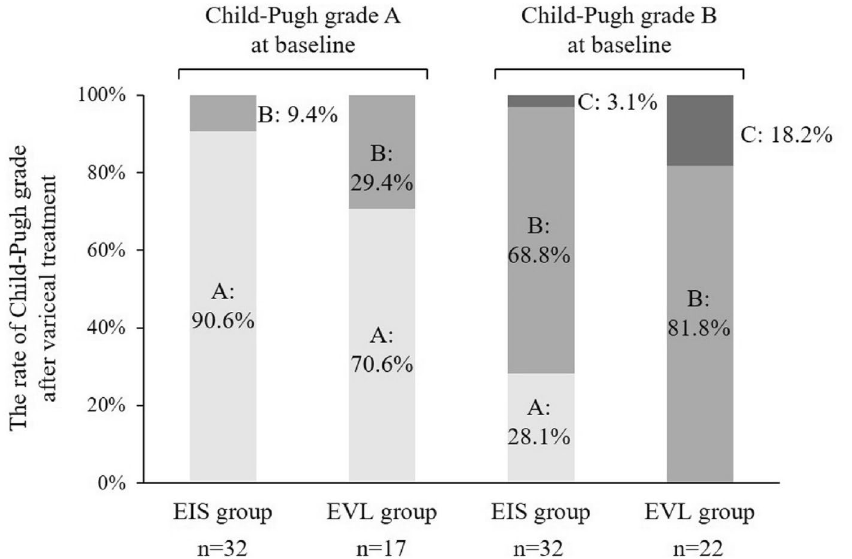
Figure 2. Change of Child–Pugh grade before and after variceal treatments. In patients with Child–Pugh grade A, the rate of maintaining Child–Pugh grade A was higher in the EIS group (90.6 vs 70.6%, p = 0.11). In patients with Child–Pugh grade B, the rate of improving to Child–Pugh grade A was significantly higher in the EIS group (28.1 vs 0.0%, p = 0.015).